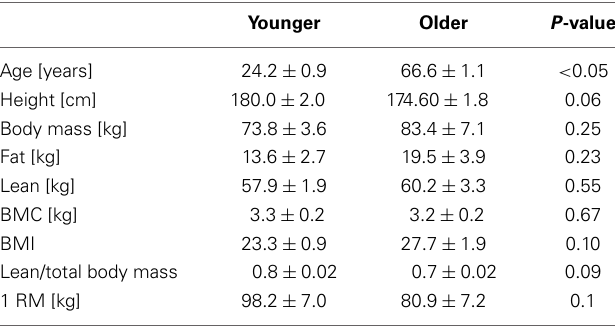
Table 2 | Subjects’